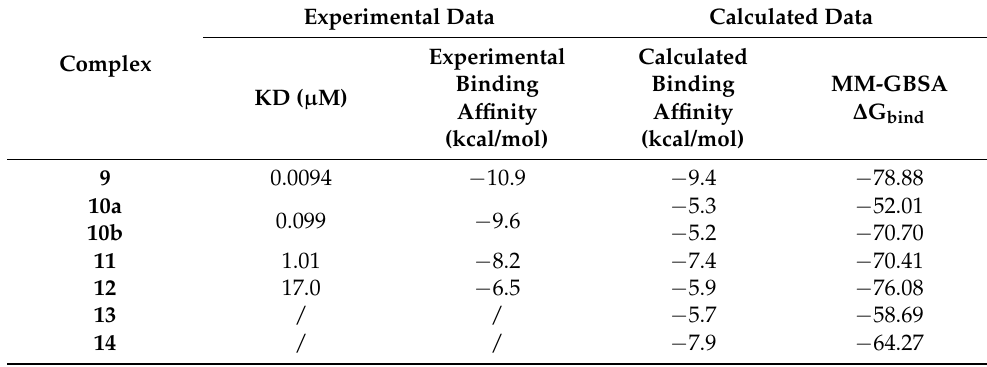
Table 7. Calculated docking score and MM-GBSA ∆ G bind for the 6 tested compounds ( 9 – 14 ).